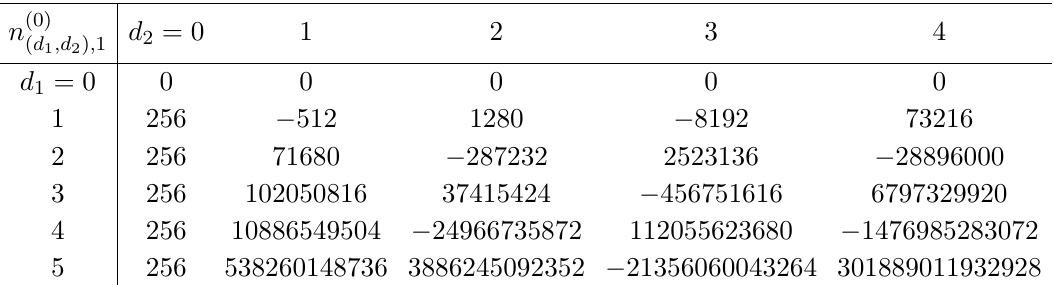
Table 7 . Genus 0 torsion refined Gopakumar-Vafa invariants with Z 2 charge 1